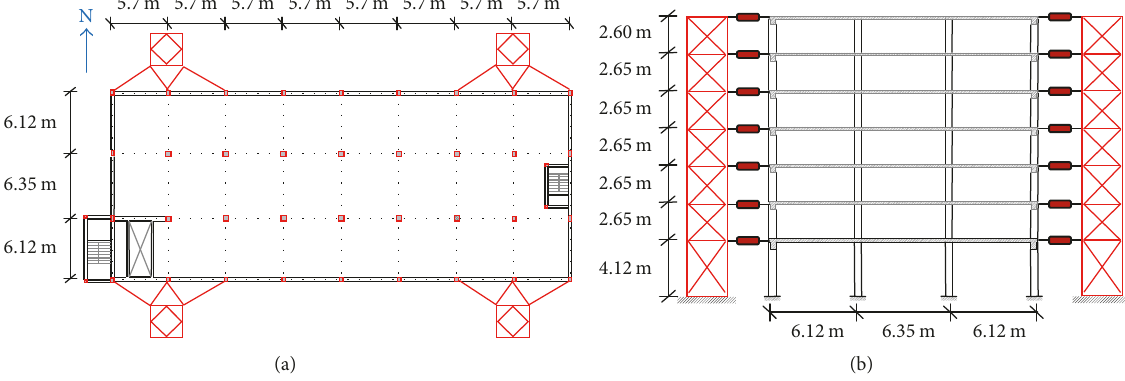
Figure 2: Van Nuys Building retrofitted with four fixed-based towers: (a) planar view and (b) transverse N-S section.